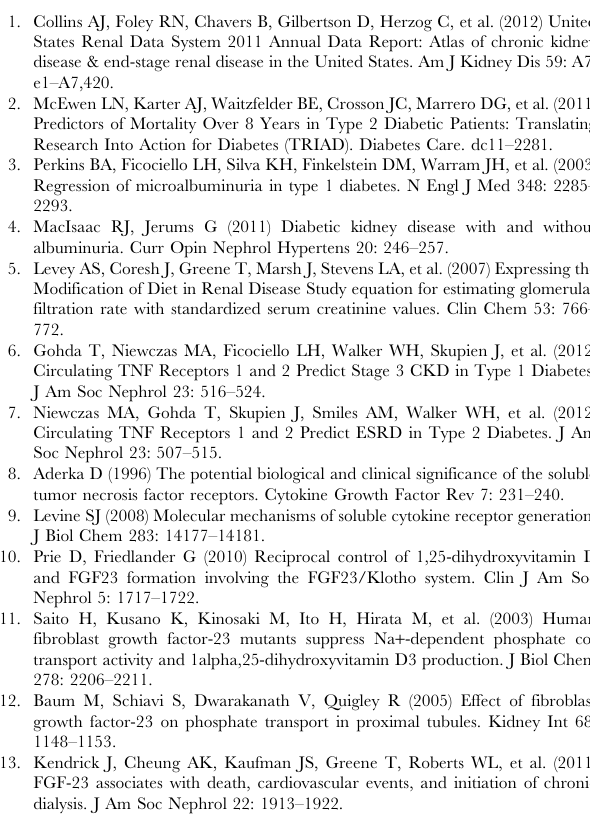
Table S1 All-cause mortality in subjects with T2D stratified by quartiles of FGF-23 and TNFR1. Table S2 Univariate and multivariate Cox proportional hazard models assessing risk of cardiovascular mortal- ity adjusting for relevant baseline clinical characteris-